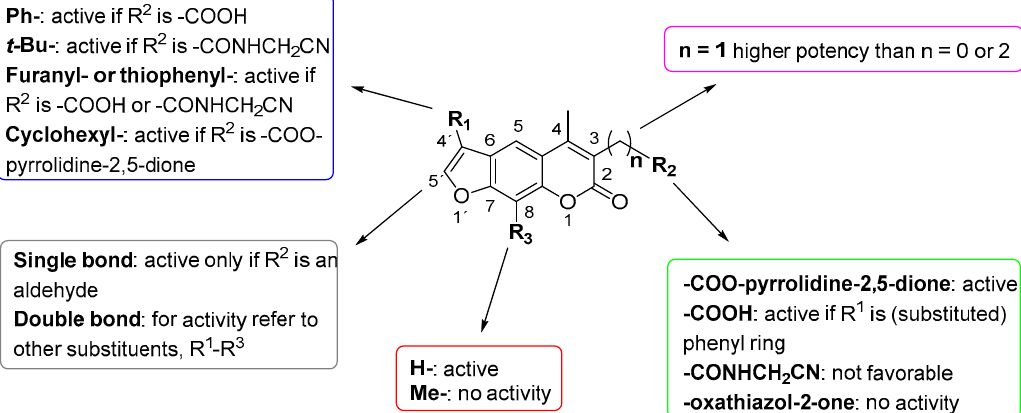
Figure 4. The summary of the SAR study of psoralen derivatives targeting the Mtb proteasome.